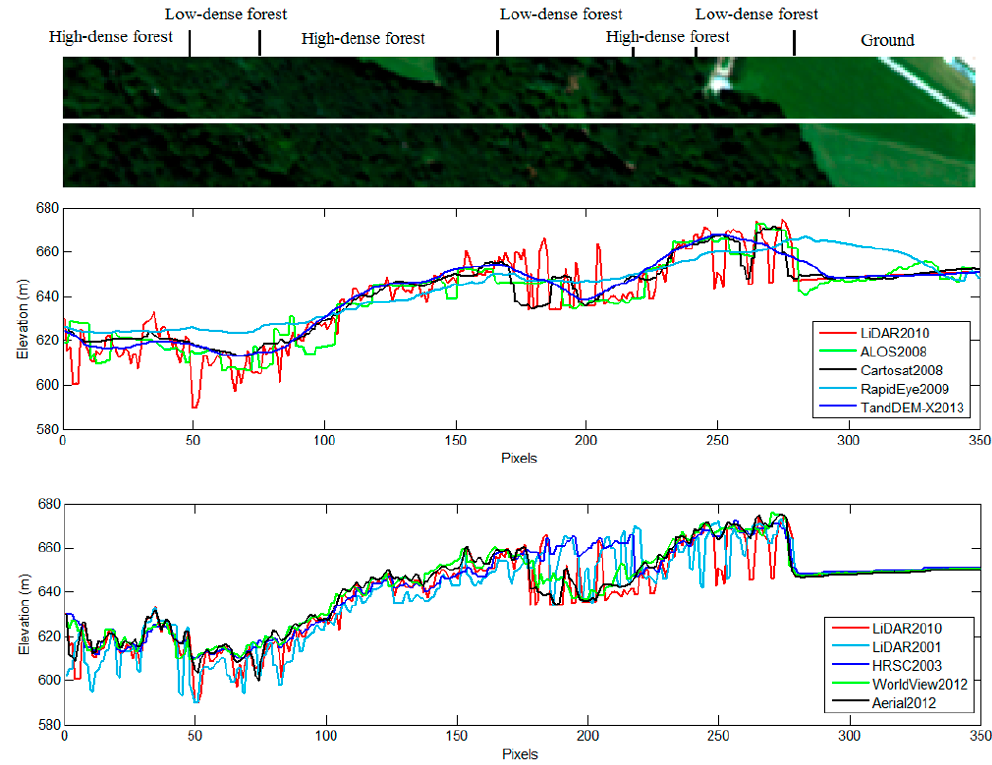
Figure 4. Profiles of the DSMs covering low-dense forest, high-dense forest and ground areas. (The DSMs are separated into two groups—above: moderately-high resolution DSMsl and below: very high resolution DSMs.)